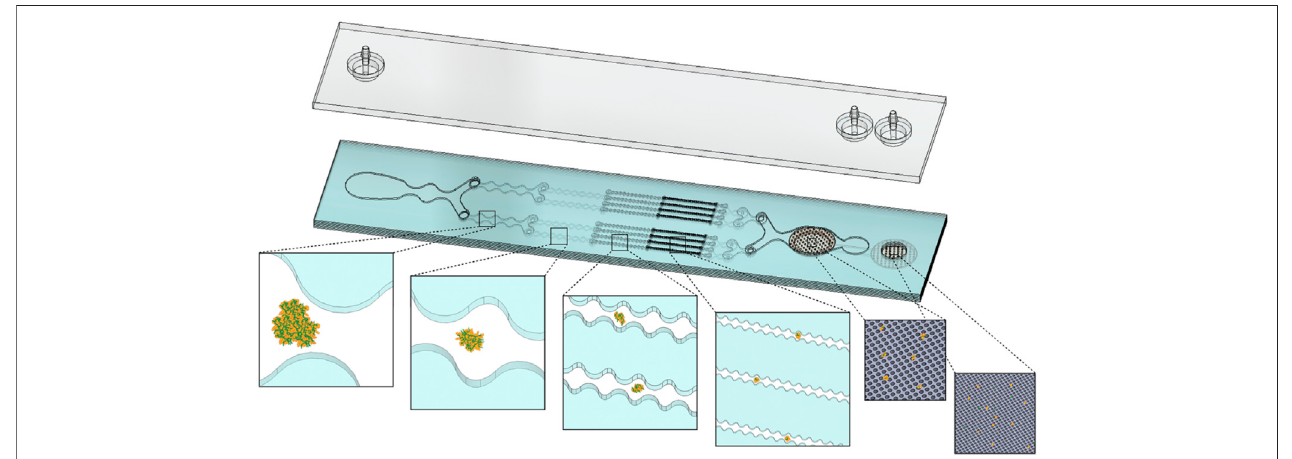
FIGURE 1 | Schematic representation of the Integrated Disaggregation and Filtration (IDF) device. Large aggregates containing high extracellular matrix (ECM) content,suchasdigestedtissue,areexposedtostepwiseincreasesinshearstressthroughoutthebranchingchannelarrayasthewidthnarrowsfrom1 mmto125 µm. Cell aggregates are held together via through cell-cell (dark orange perimeter) and cell-ECM (green fi bers) interactions. As ECM is digested by collagenase, the channel array gradually reduces aggregate size via hydrodynamic shear forces. The smallest channels and nylon mesh membranes then break down the cell-cell interactions that hold together the smallest aggregates and clusters. Channels, cell aggregates, and membrane pore sizes are not shown to scale.